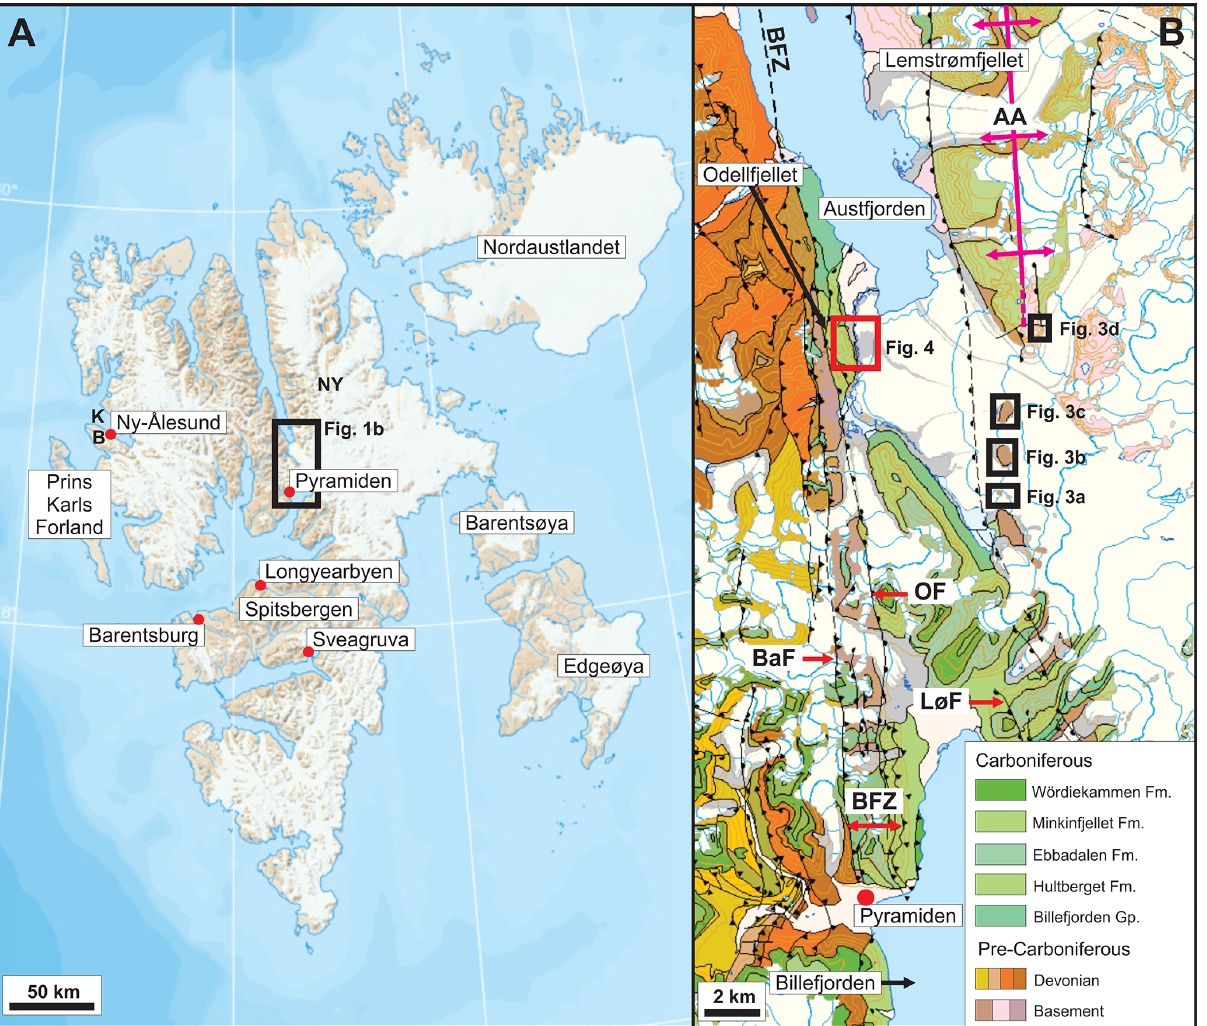
Figure 1. (a) Topography map of Spitsbergen, Svalbard. Modified from https://toposvalbard.npolar.no; last access: 18 December 2018. Ab- breviations are as follows: B – Brøggerhalvøya; K – Kongsfjorden; NY – Ny-Friesland. (b) Geological map of the Billefjorden–Austfjorden area, the location of which is shown in (a) . The location of studied outcrops is shown by a red frame. The red double arrow shows the width of the Billefjorden Fault Zone (BFZ) at Pyramiden, in Billefjorden. This fault is composed of two main segments: the Balliolbreen Fault and the Odellfjellet Fault. The Atomfjella Antiform is shown in pink. Areas shaded in white represent glaciers. The map is from sval- bardkartet.npolar.no. Abbreviations are as follows: AA – Atomfjella Antiform; BaF – Balliolbreen Fault; LøF – Løvehovden Fault; OF – Odellfjellet